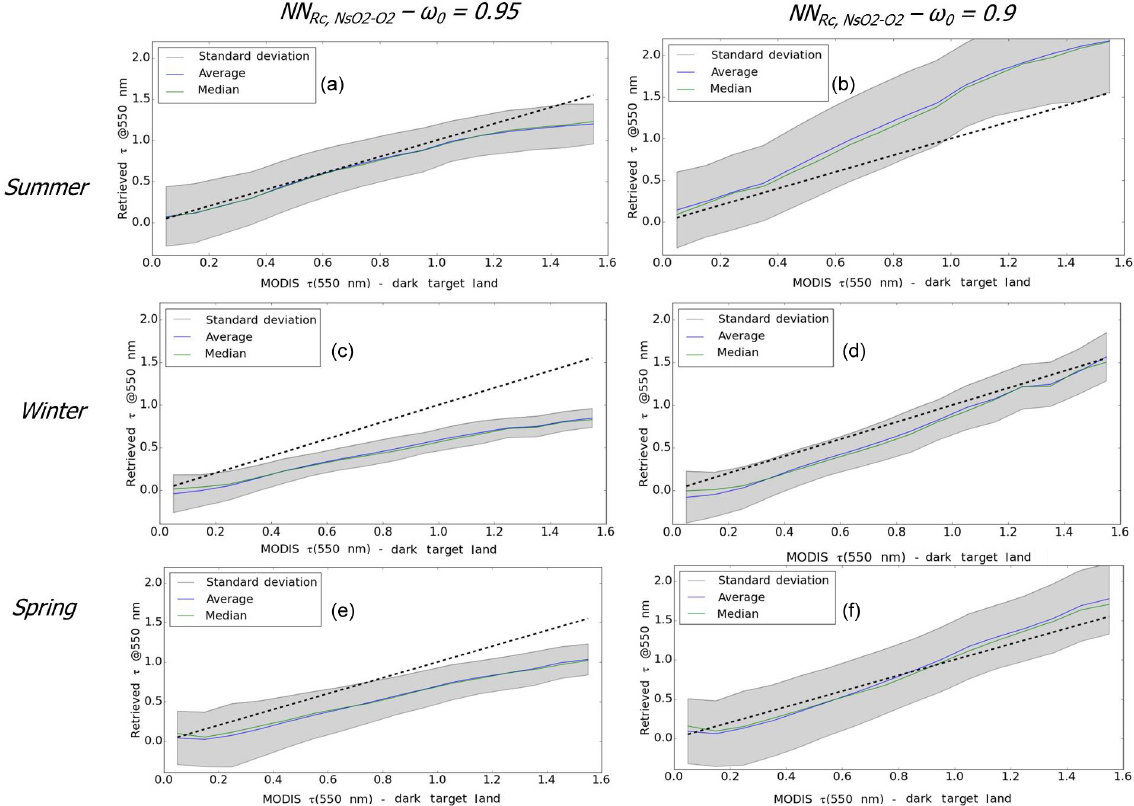
Figure 10. Collocated MODIS Aqua and retrieved OMI τ (550nm) based on the OMLER surface albedo over East China for cloud-free scenes and summer, winter and spring seasons. Statistics are computed over 3 years, 2005–2007: (a, c, e) assumed aerosol model with ω 0 = 0.95; (b, d, f) assumed aerosol model with ω 0 = 0.9.